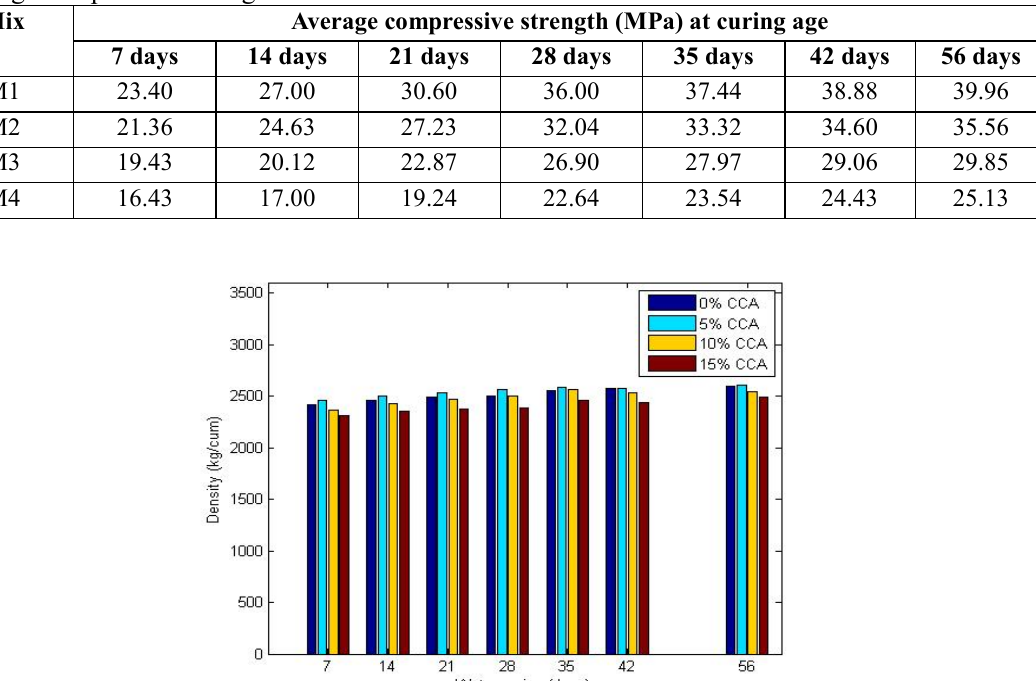
Fig. 2. Density of CCA replaced cubes at different curing ages (kg/m 3